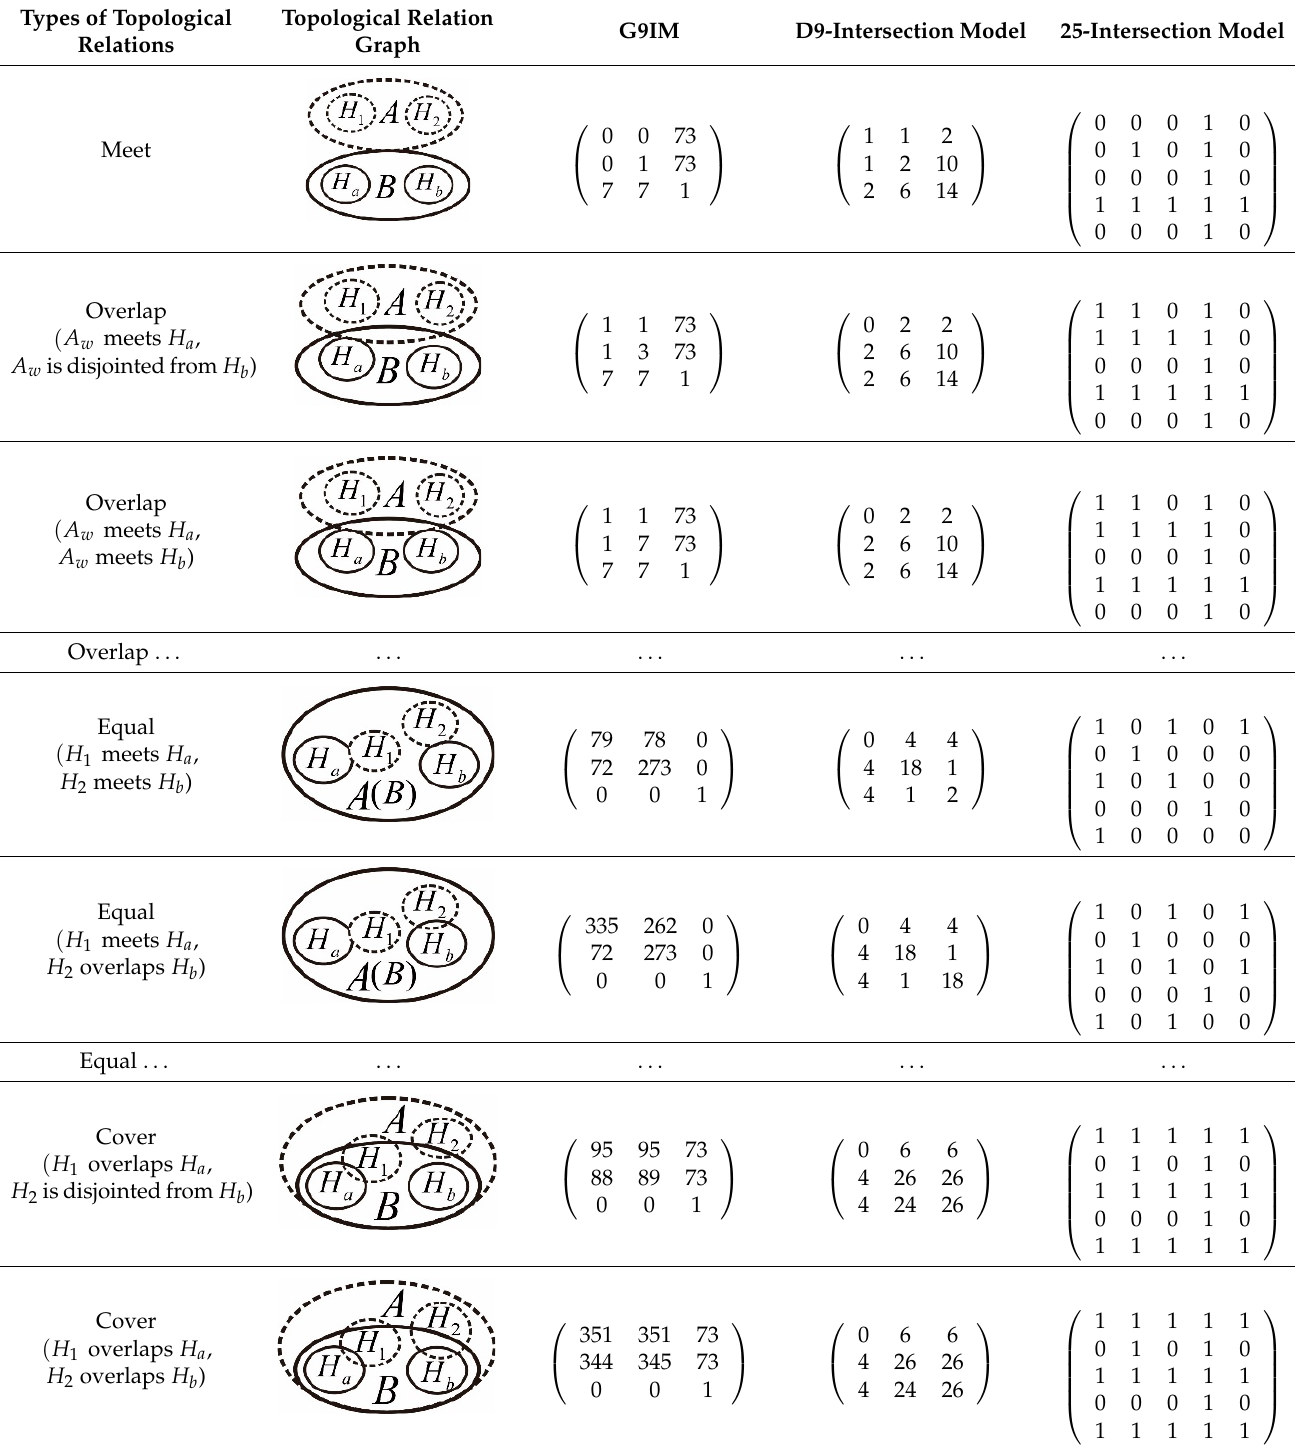
 Table 4. Describing results of topological relations between regions with holes using three types of